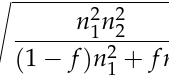
𝑛 − 𝑛 (cid:3032) (cid:3042) is the induced birefringence. As a linear approximation, the effective ordinary